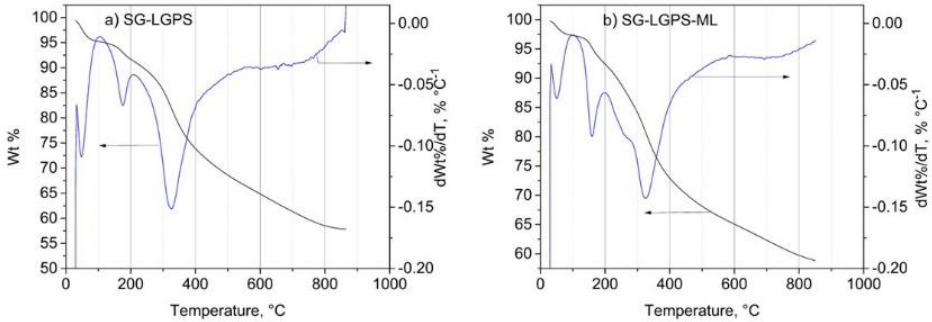
Figure 7. Thermograms of ( a ) pristine SG-LGPS and ( b ) SG-LGPS-ML.